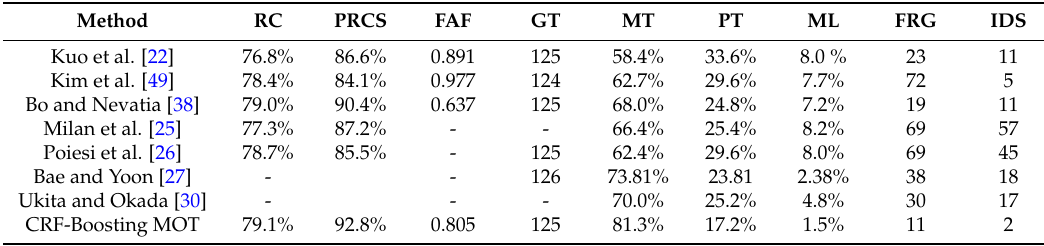
Table 5. Performance evaluation on ETH.